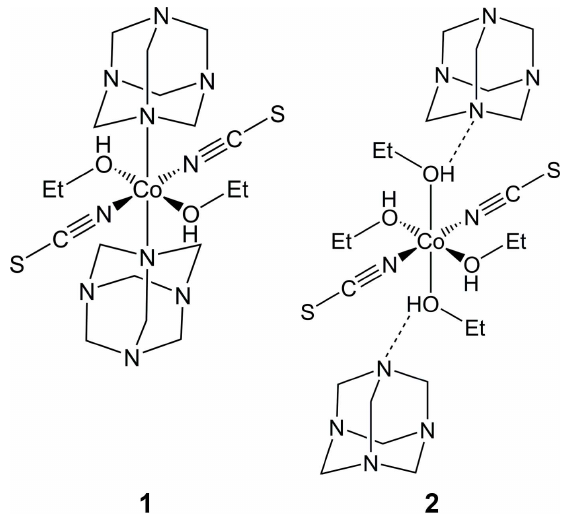
Figure 2 Crystal structure of compound 2 with labeling and displacement ellipsoids drawn at the 50% probability level with O—H (cid:2)(cid:2)(cid:2) N hydrogen bonding shown as dashed lines. Symmetry codes for the generation of equivalent atoms: (i) (cid:4) x (cid:4) 1, (cid:4) y , + z ; (ii) y (cid:4) 1 (iv) 1 (cid:4) x , 1 (cid:4) y , + z ; (v) y , (cid:4) x (cid:4) 1, (cid:4) z ; (vi) (cid:4) y (cid:4) 1, + x , (cid:4) z